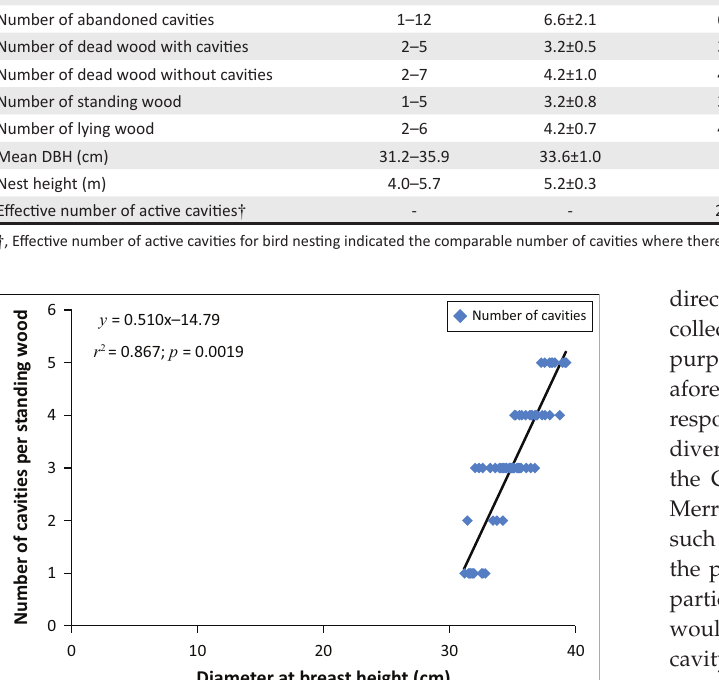
Number of dead wood without cavities